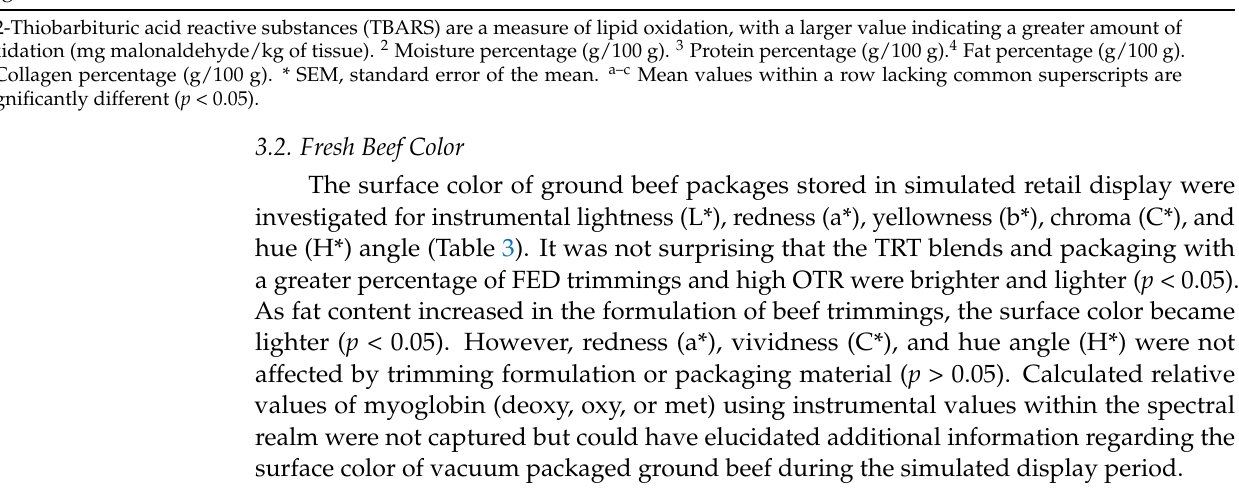
Table 3. Influence of packaging film and lean trimmings on instrumental fresh surface color of ground beef during a simulated retail display shelf